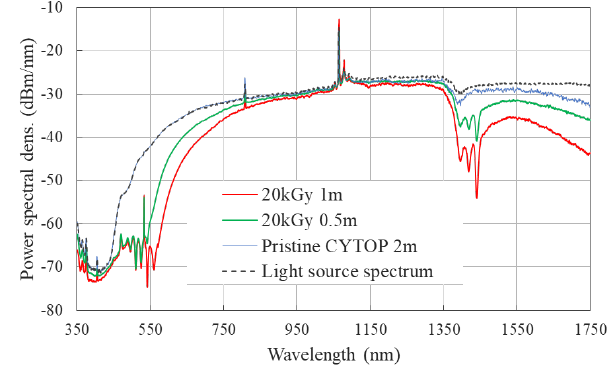
Fig. 3. Typical spectra of the light source, pristine 2-m POF, and irradiated POFs during the cut-back loss